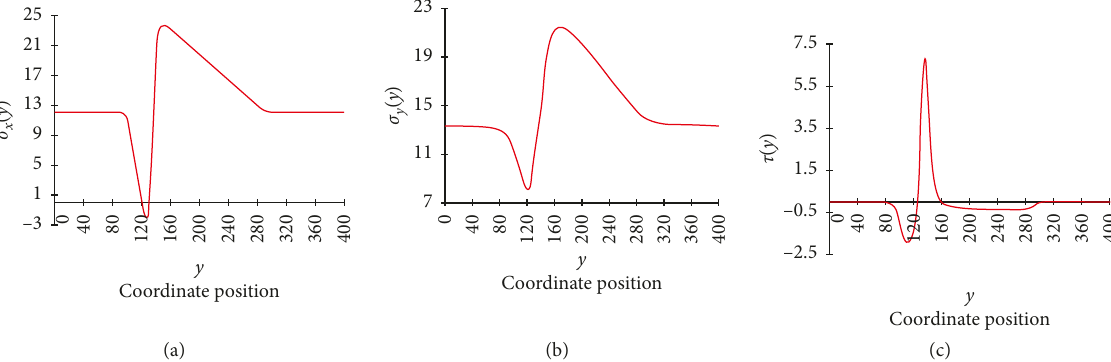
F IGURE 9: Dynamic stress variation curves of point M. (a) Vertical stress cloud atlas. (b) Horizontal stress cloud atlas. (c) Shear stress cloud atlas.